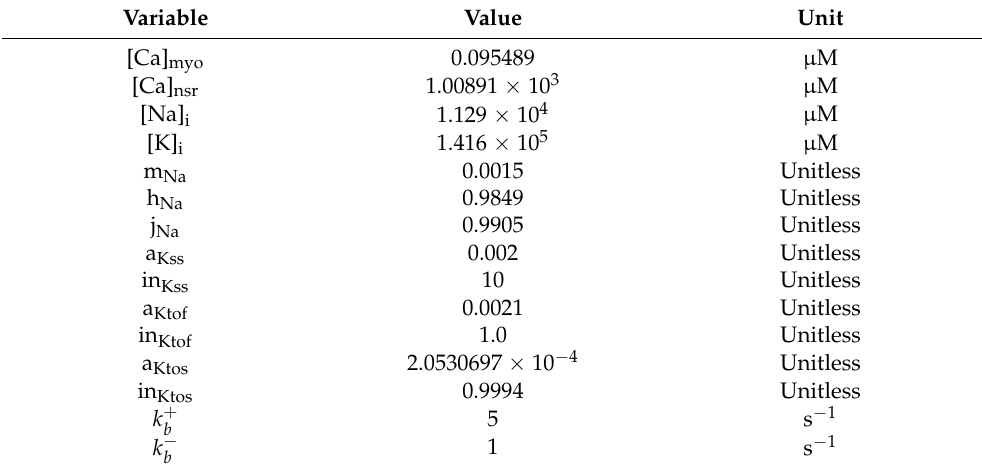
Table A1. State Variables and initial conditions.